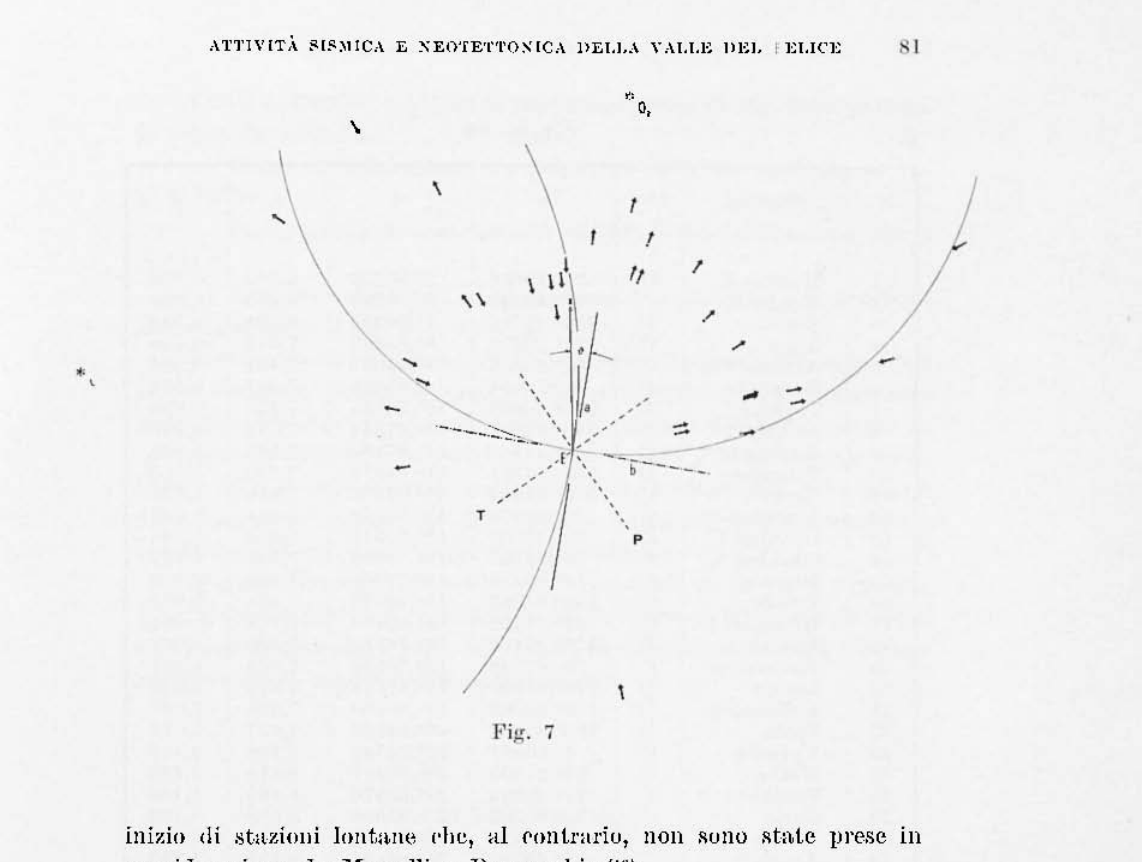
inizio di staziolli lOlltane ('h e, al f'ontl'al'iu, non suno state prese in considerazione da }'Ial'celli e Pannoechht (]"). I niine, nell]intellto e Ili ('0111Ilietare questa 1'i{'er{'a c di put,er })l'U (ltu'l'e q1Ulkhe altro elemento a sostegno della suverlicialitil' dei tene· mot,i del BcIif'e, si sono eOl1sillemti i versi Ilei Ilrimi UUll1ùl;i della SeO!lSll. }lrin{'ivale C';. fii JI = 5,9) in oltre trenta Htazioni. I Ilat,i riH'('oIti, unitamente agli element,i ('aleolati IleI' J'a11}lreHen· tare in proiezione sh~l'eogTa!i('a, la dist,['ibuzione delle dilatazioni e delle cornJ!/'(!s.~i01li, sono riportati in 'rah. IV. La {'oHtl'llziolW gl'a!i{'a ('Ollse· guent,e è quella di Fig. i, uve a e b !lonu le tangenti alle eirconferem:e di centro O, e O rislleUivamente, illterse('a,nt,iHi ortogOllllohnente nel· 2 l'evieent.ro E = I, e delimit.ant.i le due euvvie Ili ZOlle a dillllazione e compnwSlOlUJ. ('om}lIessivllolnente l'iIHlividull,zione gra,lica Ild }liallO Ilrin('ipale c del viano lmsiliario, aventi nel viano di SUIJCrlicie le traece a e b l'i· s}le\.t.ivament.e, (leve ritenersi soddisf:teente. Infatti, la l'dativa ab· bondanza, di (1a.t.i nel J e nel IV quadrallte, nOll('h{~ la fa,vol'cvole